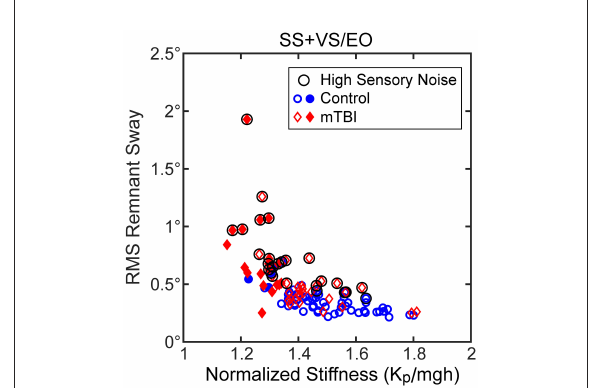
FIGURE6 Relationships between RMS values of remnant CoM sway and normalized stiffness ( K p / mgh ) for the SS + VS/EO test condition (simultaneous pseudorandom surface and visual tilt stimuli). Data are from control subjects (blue circles) and mTBI subjects (red diamonds) with filled symbols indicating the 4 control and 19 mTBI subjects with both low stiffness and long time delays based on 10 th percentile and 90 th percentile values of control subject data for normalized stiffness and time delay parameters, respectively (see Figure 7). There is some evidence of a hyperbolic relationship between remnant sway and K p / mgh but there are outliers that show greater remnant sway than others at a given K p / mgh value. These outlying points are associated with subjects with greater internal sensory noise as indicated by the black circle symbol for subjects with internal sensory noise values greater than the 90 th percentile value for control